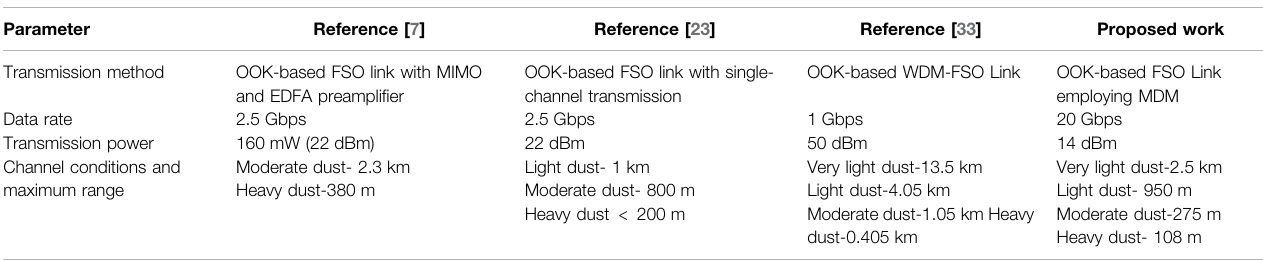
TABLE 3 | Comparison of the transmission performance of the proposed system with recent